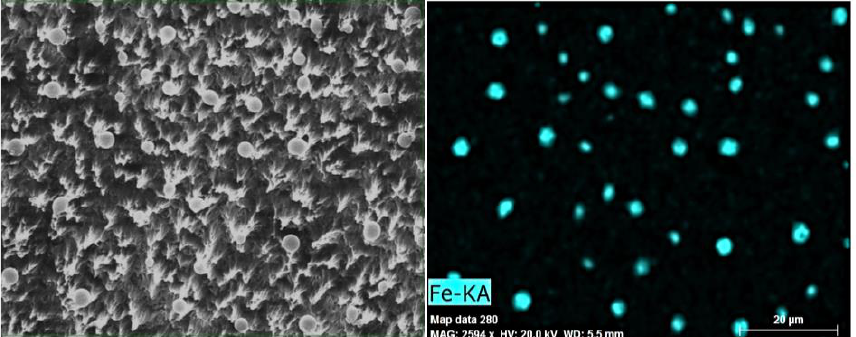
Figure 9. SEM image (left) and corresponding Scanning Electron Microscopy-Energy-dispersive X-ray spectroscopy (SEM-EDX) map of iron (right) of a polytetrafluoroethylene (PTFE) sample treated by plasma at 300 W for 15 min. Adapted with permission from [52]. Copyright 2019 Elsevier B.V.